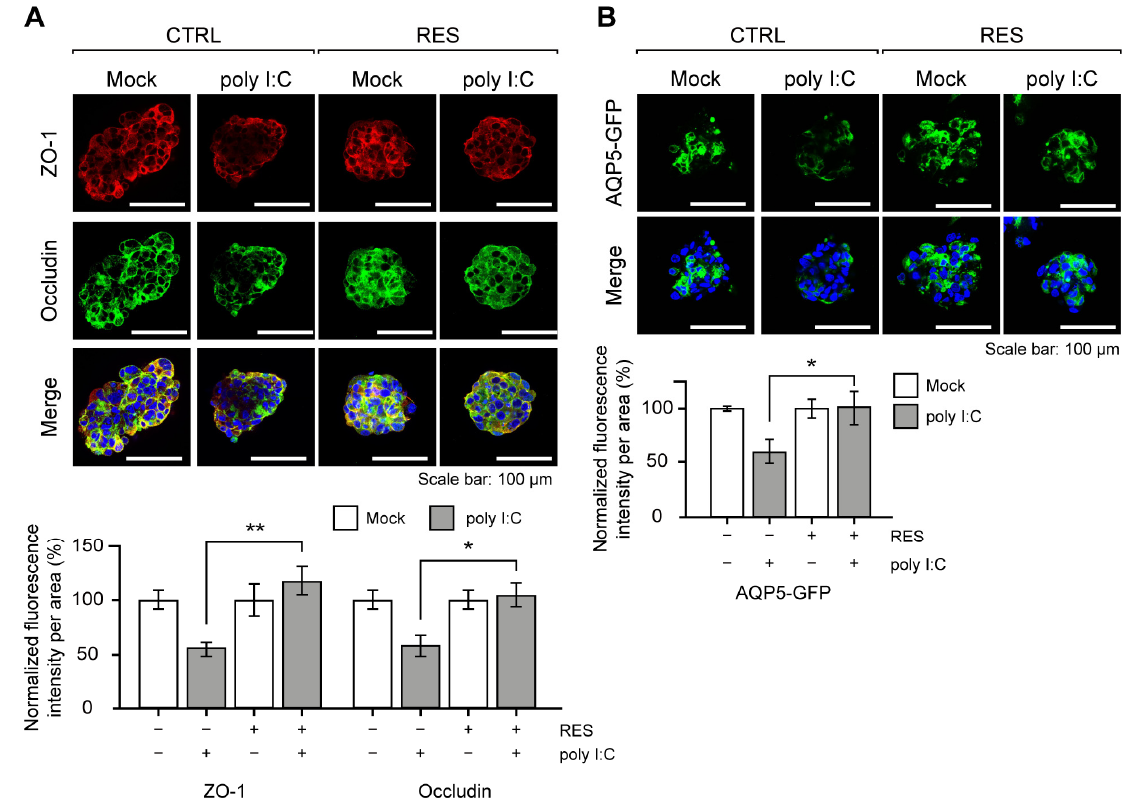
Figure 2. RES pretreatment rescued SS-related protein expressions. ( A ) Representative images of ZO-1 and occludin upon poly I:C transfection with or without RES pretreatment. The quantification of ZO-1 and occludin expressions is presented as the mean fluorescence intensity per spheroid. Intensities were normalized to the data from each experimental group cultured without poly I:C. n = 3 and error bars are s.e.m. ( B ) Visualization of GFP-tagged AQP5 expression upon poly I:C transfection. The scale bar represents 100 µ m. The mean fluorescence intensities were normalized to the data from each experimental group cultured without poly I:C. In the bar graphs, the “–“ sign indicates RES-untreated/Mock-transfected, whereas the “+” sign indicates RES-treated/poly I:C-transfected. n = 3 and error bars are s.e.m. All statistical significances were calculated using one-tailed Student’s t-tests; * p ≤ 0.05, ** p ≤ 0.01.